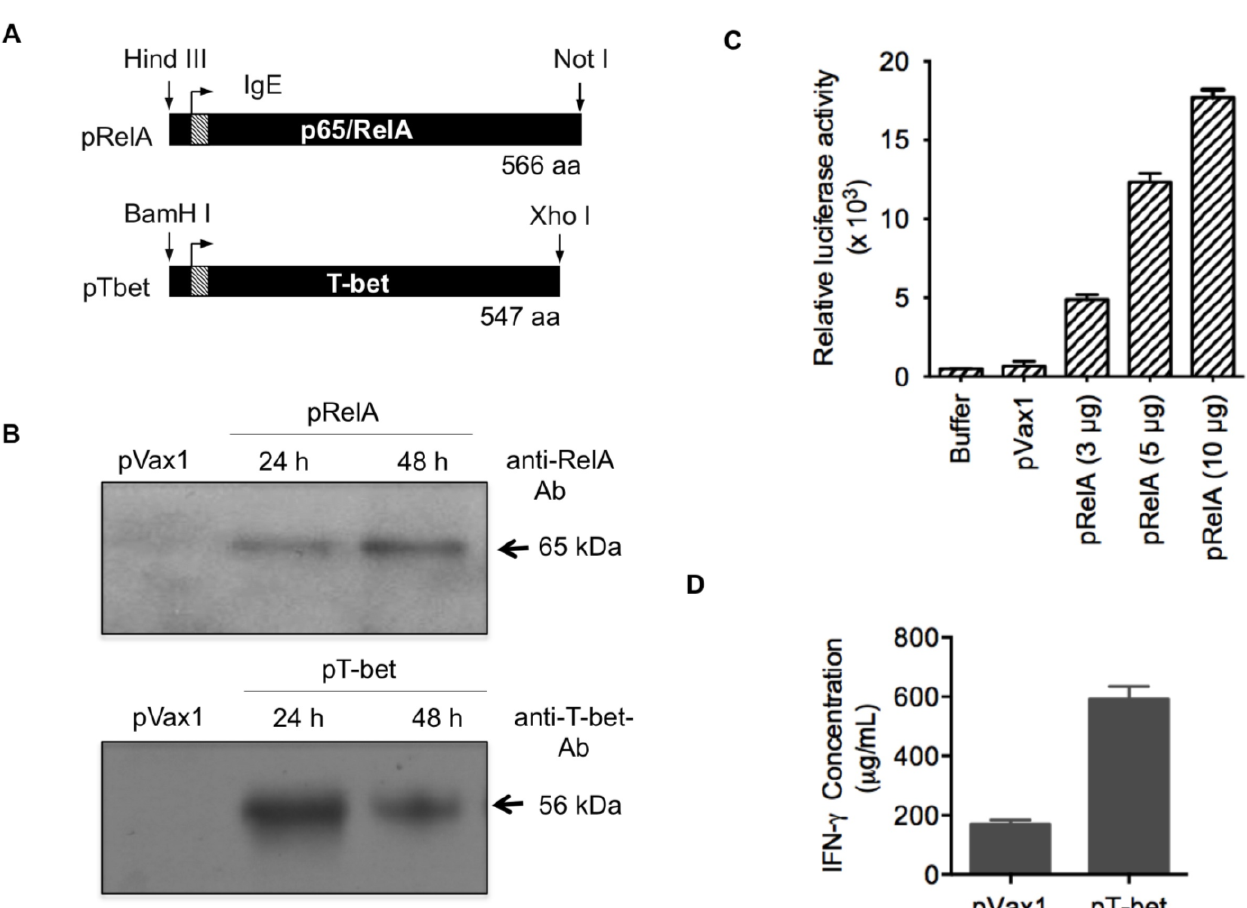
Figure 1. Molecular adjuvant construction and expression. ( A ) Mouse RelA or T-bet primary sequences were genetically optimized, synthesized, and then subcloned into modified pVax1 expression vectors. Optimization entailed inclusion of a IgE leader peptide (IgE), preceded by a Kozak sequence, fused at the N -terminus. The figure indicates the restrictions enzymes used for subcloning, the translation initiation site (forward arrow), IgE leader peptide (IgE; hatched bar), protein length (aa), and transgenes (black with white lettering); ( B ) Protein expression from the nuclear extract was analyzed by Western immunoblotting following transfection of HEK 293T cells with pRelA, pTbet, or empty vector control (pVax1). The relative size (kDa) of the proteins are determined by detection analysis using protein-specific Abs as indicated; ( C ) Over expression of RelA potently induces κB dependent transcription. HeLa cells were transiently transfected with a NF-κB-dependent luciferase reporter gene together with expression vectors encoding RelA/p65. The cotransfected cells were subsequently grown for 48 h, and the luciferase activity was determined as described in the Materials and Methods; ( D ). Overexpression of T-bet stimulates production of IFN-γ: Naive CD4 T cells were transfected with either pT-bet or pVax1 and stimulated with anti-CD3 plus anti-CD28 followed the measurement of IFN-γ production by enzyme-linked immunosorbent assay (ELISA) as described Materials and Methods. IFN-γ levels are expressed as μ